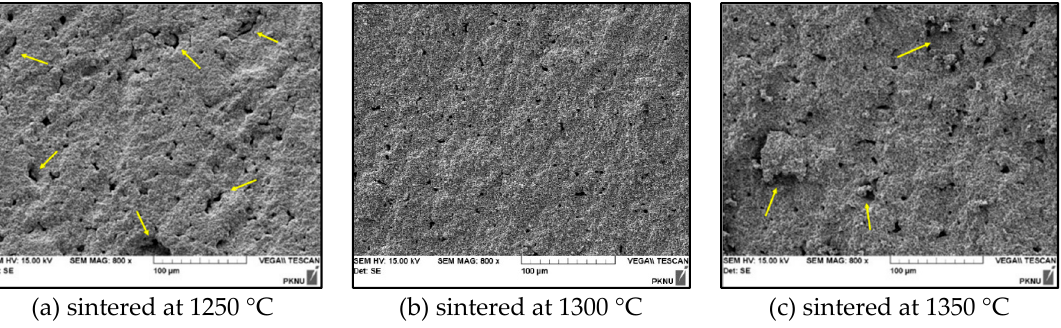
Figure 6. Effect of sintering temperature on the microstructure of the PZT ceramics (fixed 10.40 MPa of forming pressure): ( a ) sintered at 1250 °C ( b ) sintered at 1300 °C and ( c ) sintered at 1350 °C .